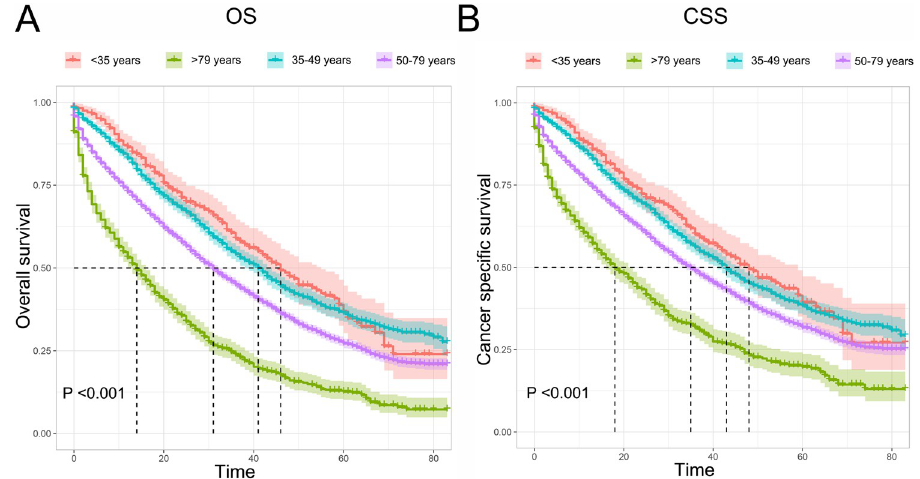
Fig 5. Kaplan-Meier curve of OS ( A ) and CSS ( B ) in MBC patients with different age. OS, overall survival; CSS, Cancer-specific survival.